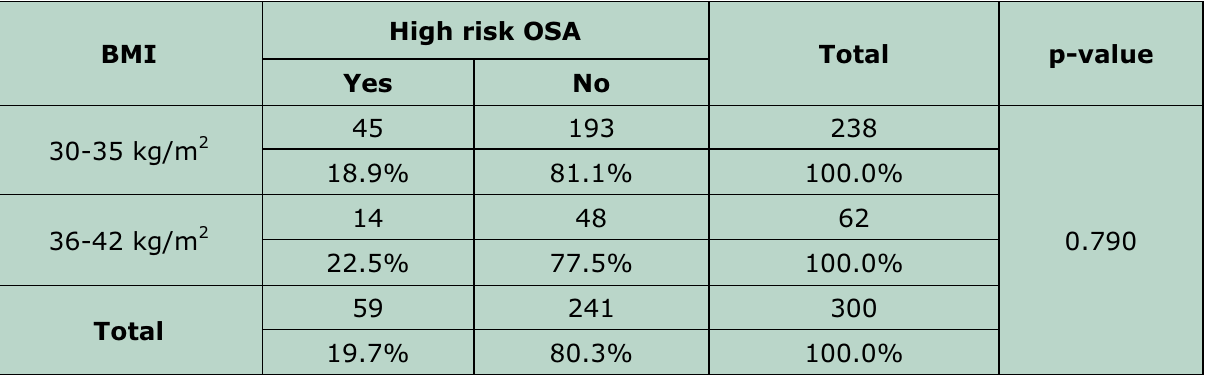
Table-V: Stratification of High risk OSA with respect to BMI. High risk BMI